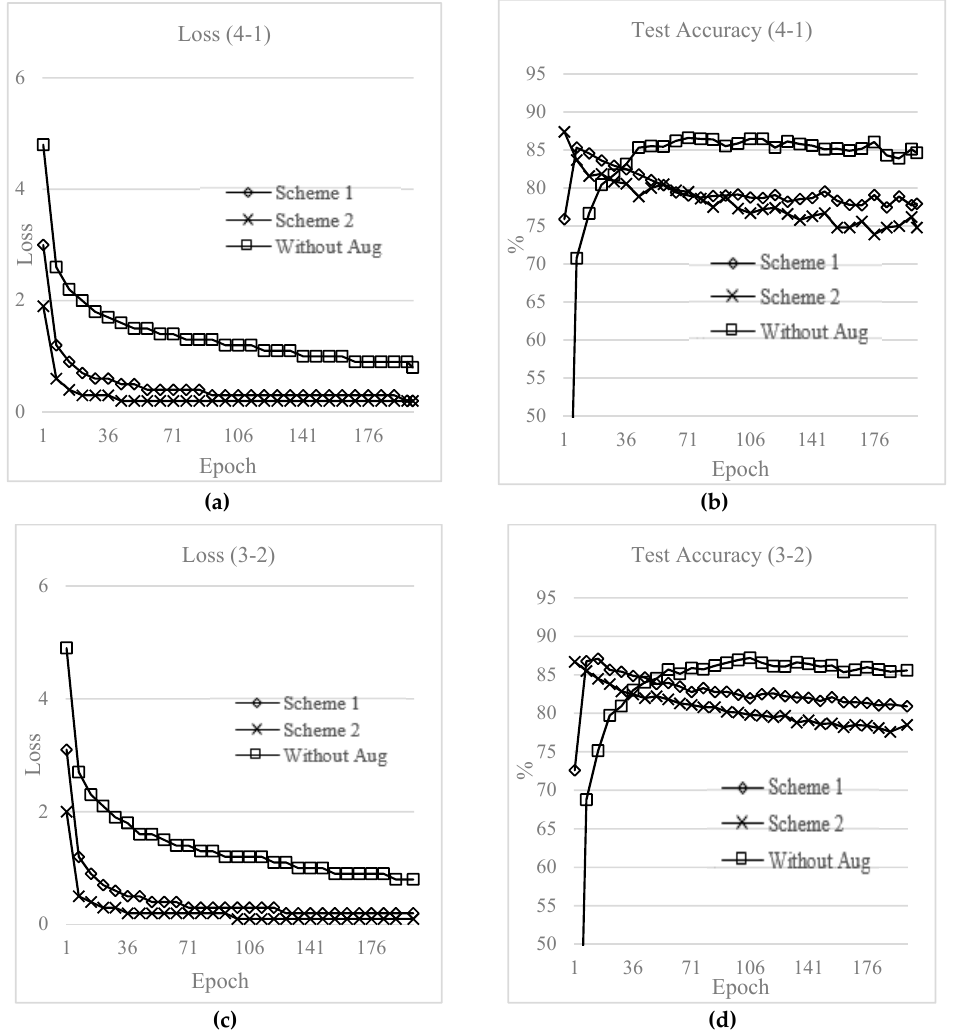
Figure 10. Lab simulation results. ( a , c , e ) Set 1 loss for the three cases. ( b , d , f ) Set 1 test accuracy for the three cases.